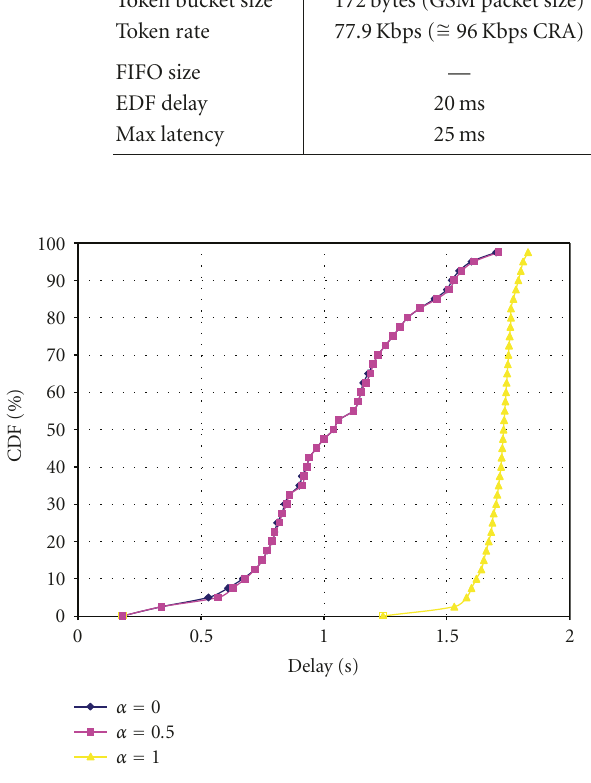
Figure 4: DAMA impact (VBR flow without FCA). Figure 5: DAMA impact on a VBR flow with FCA.